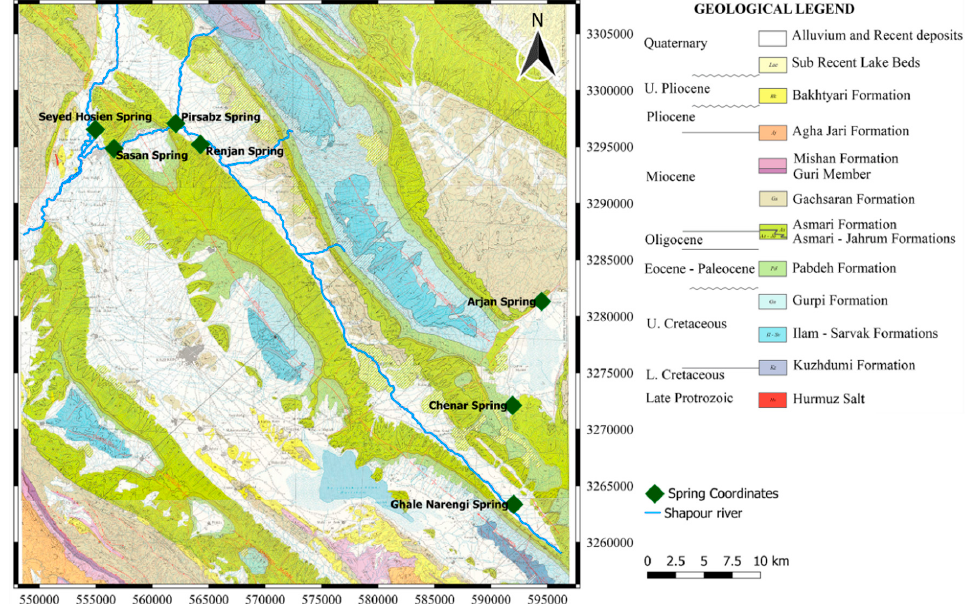
Figure 3. Map showing spring sampling points (Arjan, Sasan, Seyed Hossein, and Ghale Narenji) and other significant springs in the study area (Pirsabz, Chenar, Renjan) (modified from [47]). An automated gas-source isotope ratio mass spectrometer Finnigan Delta XP was used for the determination of the hydrogen and oxygen stable isotope compositions of the water samples. For the determination of hydrogen isotopes, samples were reacted at 750°C with chromium using a Finnigan H/Device coupled to the mass spectrometer. For oxygen isotopes, samples were equilibrated with CO 2 at approximately 15°C in an automated equilibration device coupled to the mass spectrometer. The hydrogen and oxygen isotope ratios were expressed as δ D and δ 18 O, respectively, relative to the international reference materials Vienna Standard Mean Ocean Water (VSMOW) and Standard Light Antarctic Precipitation (SLAP).